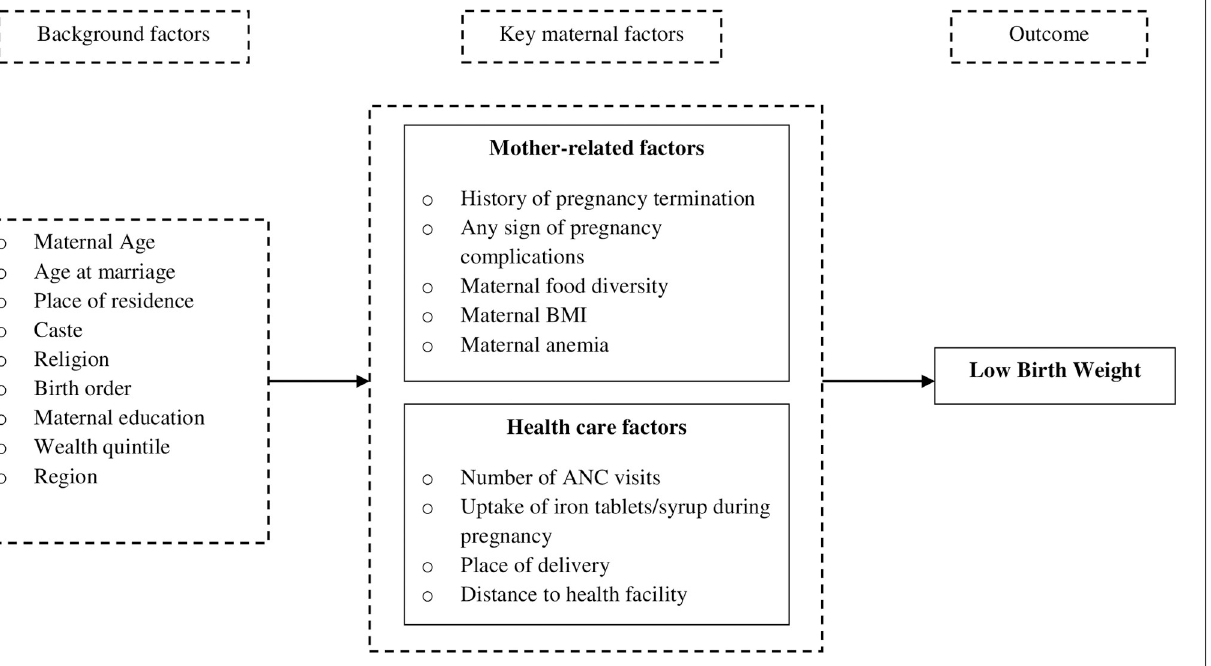
PLOS ONE | https://doi.org/10.1371/journal.pone.0244562 December31,